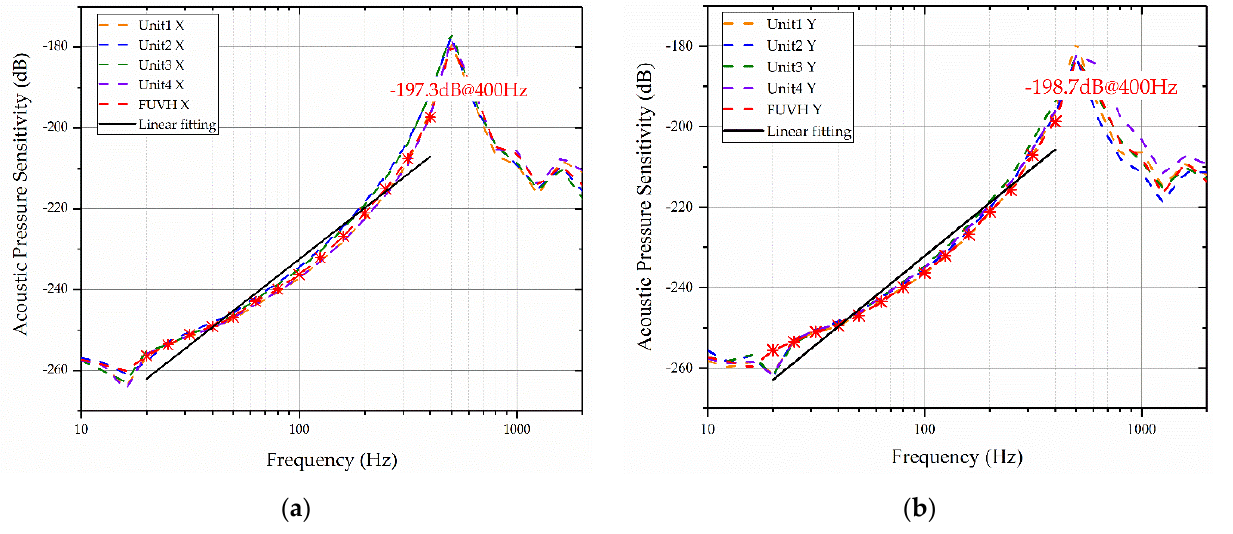
Figure 13. The sensitivity test results: ( a ) the acoustic pressure sensitivity of the X channel is − 197.3 dB@400 Hz; ( b ) the acoustic pressure sensitivity of the Y channel is − 198.7 dB@400 Hz.